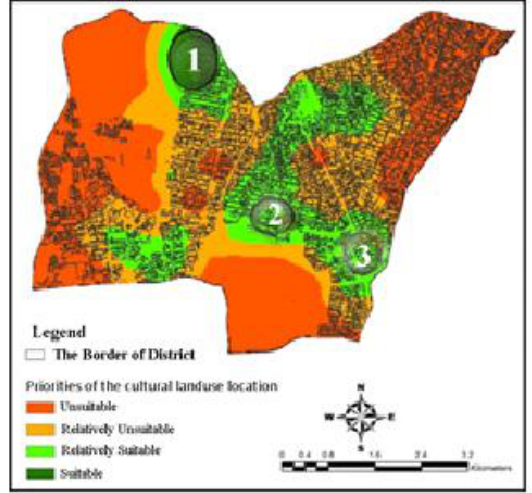
Fig. 19: Priorities of the cultural land use